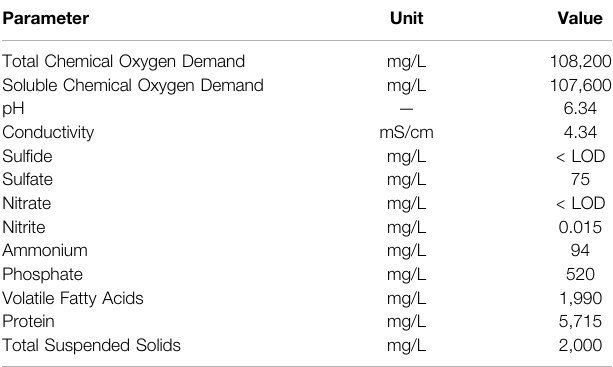
TABLE 1 | Inoculum chemical